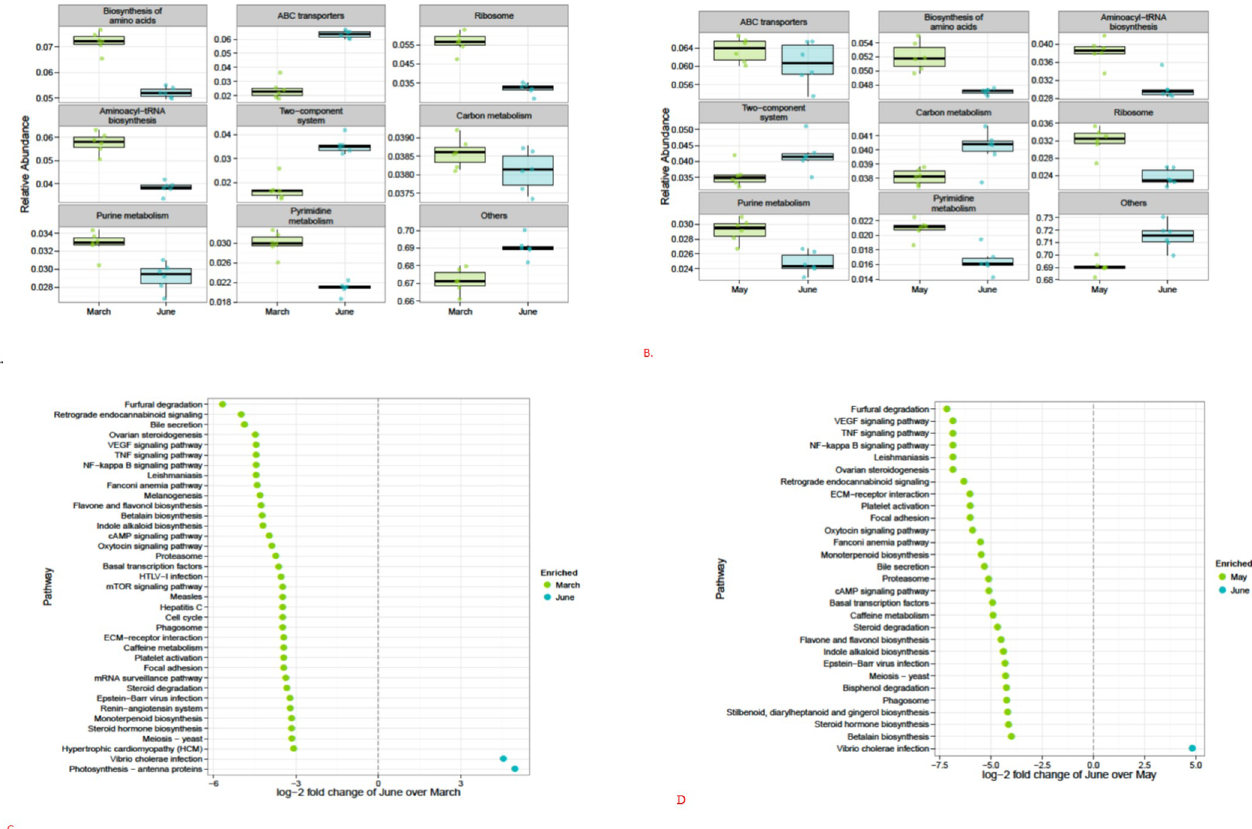
Fig 4. Proportional abundance of the top inferred pathways for March vs. June leaf (Fig 4A); May vs. June (Fig 4B). KEGG pathway prediction feature selection for March vs. June leaf (Fig 4C). There were 161 significantly different features detected out of 308 tested. Only the 37 pathways with an absolute log- 2-fold change greater than 3 and not equal to Inf or -Inf are shown. KEGG pathway prediction feature selection for May vs. June leaf (Fig 4D). Features were considered significant if their FDR-corrected P-value was less than or equal to 0.05, and the absolute value of the log-2-fold change was greater than or equal to 1. There were 121 significantly different features detected out of 308 tested. Only the 29 pathways with an absolute log-2-fold change greater than 4 are shown.